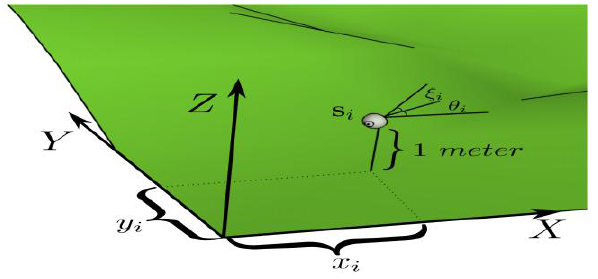
Figure 5. Free parameters ( 𝑥 𝑖 ,𝑦 𝑖 ,𝜃 𝑖 , 𝜉 𝑖 ) for the sensor 𝑆 𝑖 in environment [24].